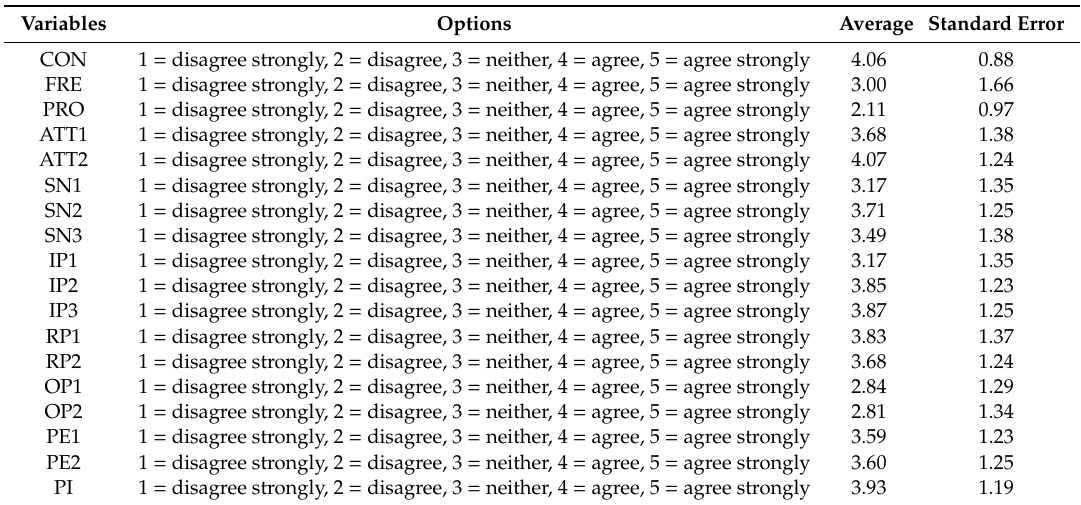
Table 2. Item average scores and standard error values.